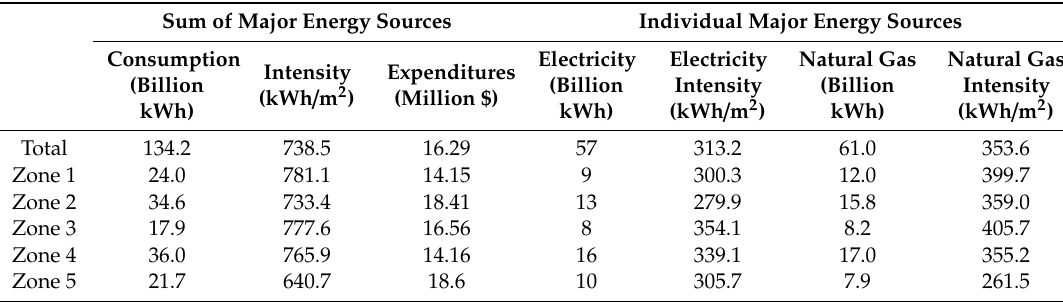
Table 5. Energy consumption and intensity by a source per climate